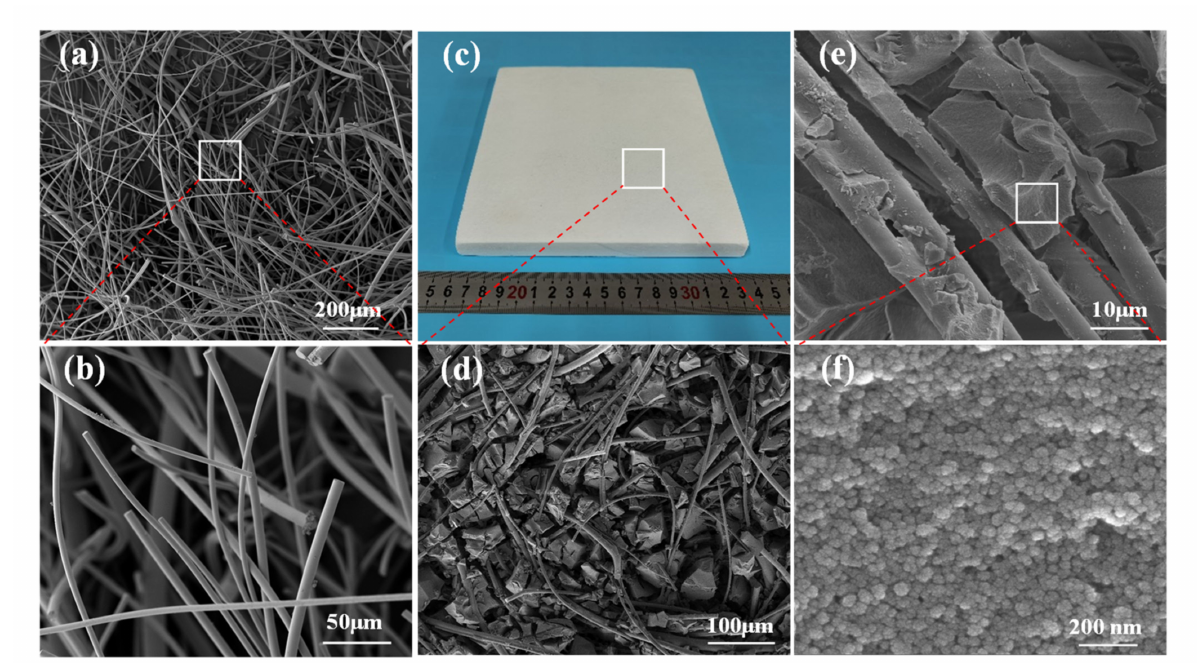
Figure 1. ( a , b ) SEM images of pure mullite fiber, ( c ) photographs of SAC, and ( d – f ) SEM images of the